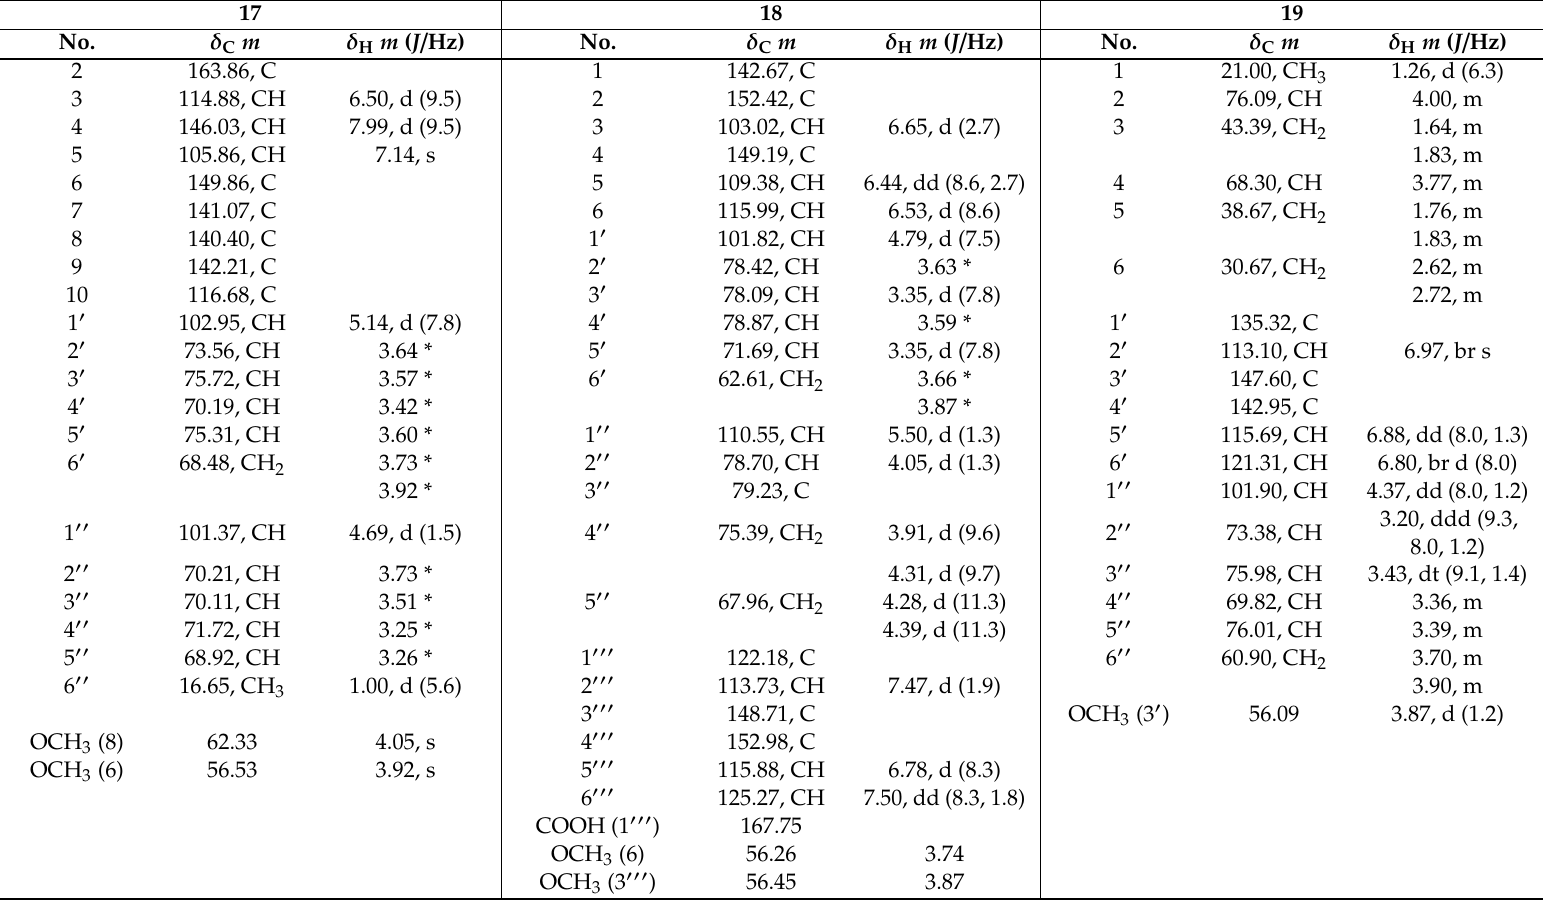
Table 1. 1 H and 13 C NMR data of compounds 17 , 18 and 19 in D 2 O ( 17 , 19 ) or CD 3 OD ( 18